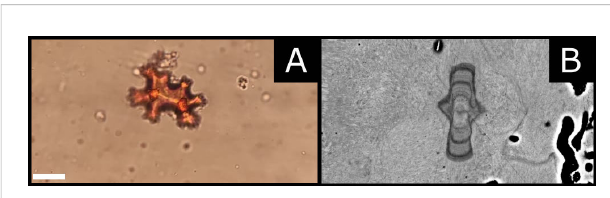
FIGURE 2 (A) Blow up of a sclerite by stereomicroscope. (B) Scanning electronic microscopy: backscattered electron mode. The image shows the internal structure of a sclerite found in the axial skeleton of a 3- to 4- year-old coral. It is possible to observe a central core and three dark and evident growth marks, representing the sclerite ’ s growth rings (scale bar 9